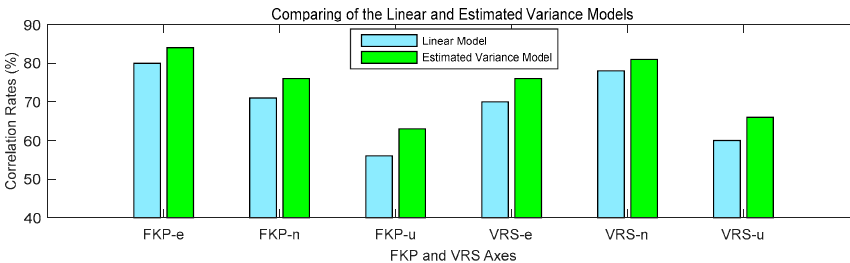
Figure 10. Comparison of the Linear and Estimated Variance Models (FKP and VRS).